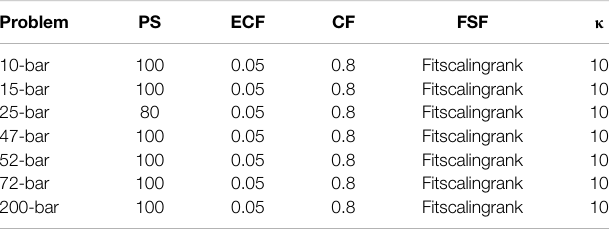
TABLE 4 | Default values for the control parameters. Their names are abbreviated as follows: PopulationSize (PS), EliteCountFraction (ECF), CrossoverFraction (CF), FitnessScalingFcn (FSF), and penalty parameter κ .